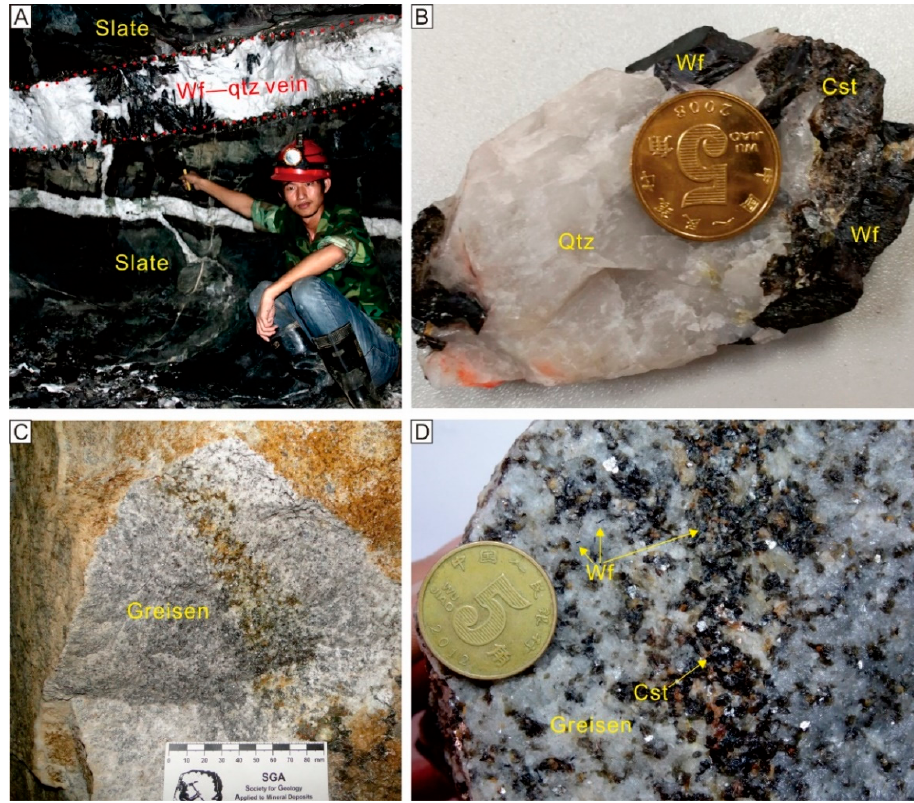
Figure 5. Two types of mineralization in the Maoping W–Sn deposit. ( A , B ) Quartz vein- type mineralization; ( C , D ) Greisen-type mineralization. Wf, wolframite; Cst, cassiterite; Qtz,